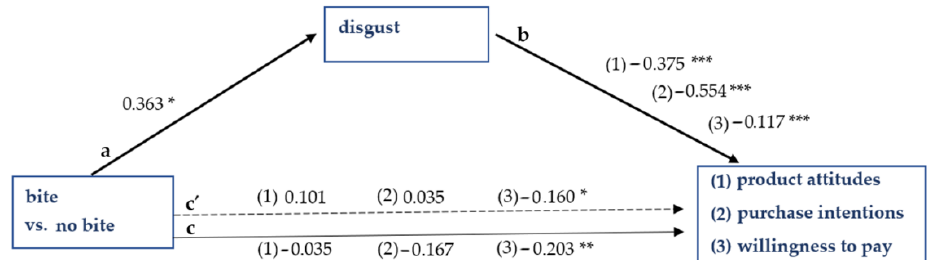
Figure 7. Results of Study 2. The effect of picture type on product attitudes, purchase intentions, and willingness to pay is mediated by disgust. Note: *** significant at p < 0.001; ** significant at p < 0.01; * significant at p < 0.05; a = effect of independent variable on mediating variable; b = effect of mediating variable on dependent variable; c’ = direct effect of independent variable on dependent variable; c = total effect of independent variable on dependent